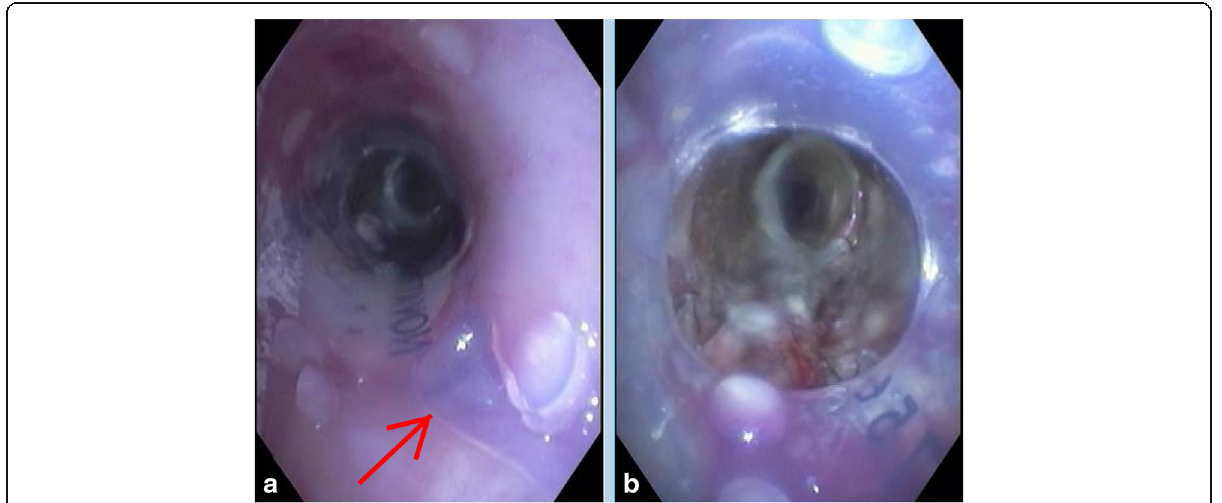
Fig. 4 Supplemental Digital Content 4. Newly placed proximal silicon tracheal stent. a . Sealed proximal tracheoesophageal fistula. b Three telescoped tracheal